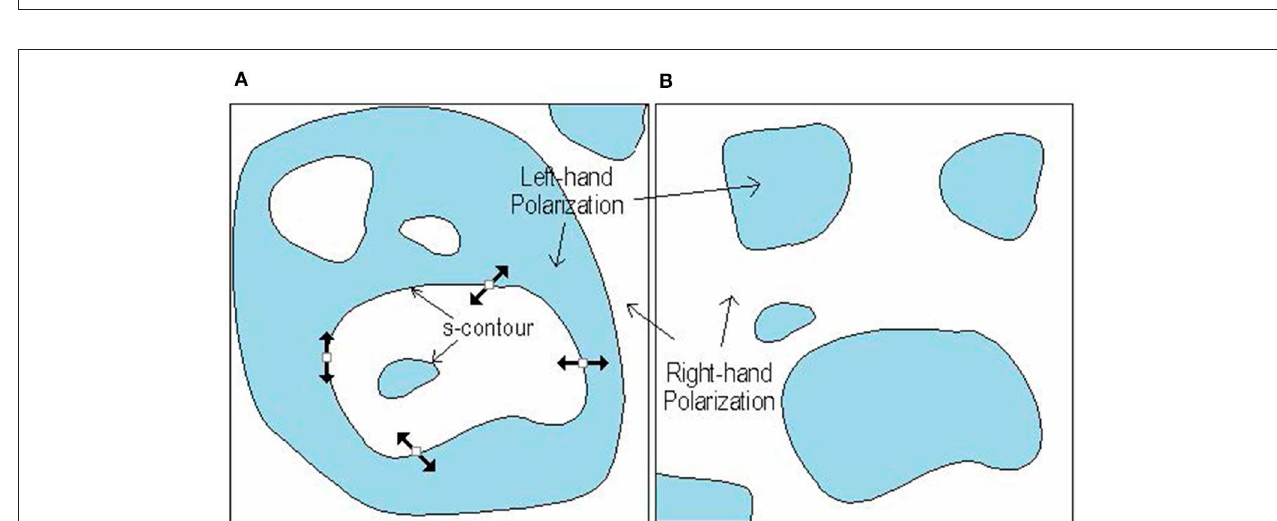
FIGURE 4 | Schematic illustration of the speckle field evolution [27].